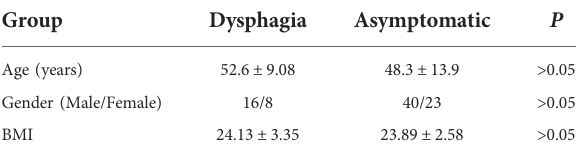
TABLE 3 Comparison of pro- and post- cervical alignment between dysphagia and asymptomatic groups